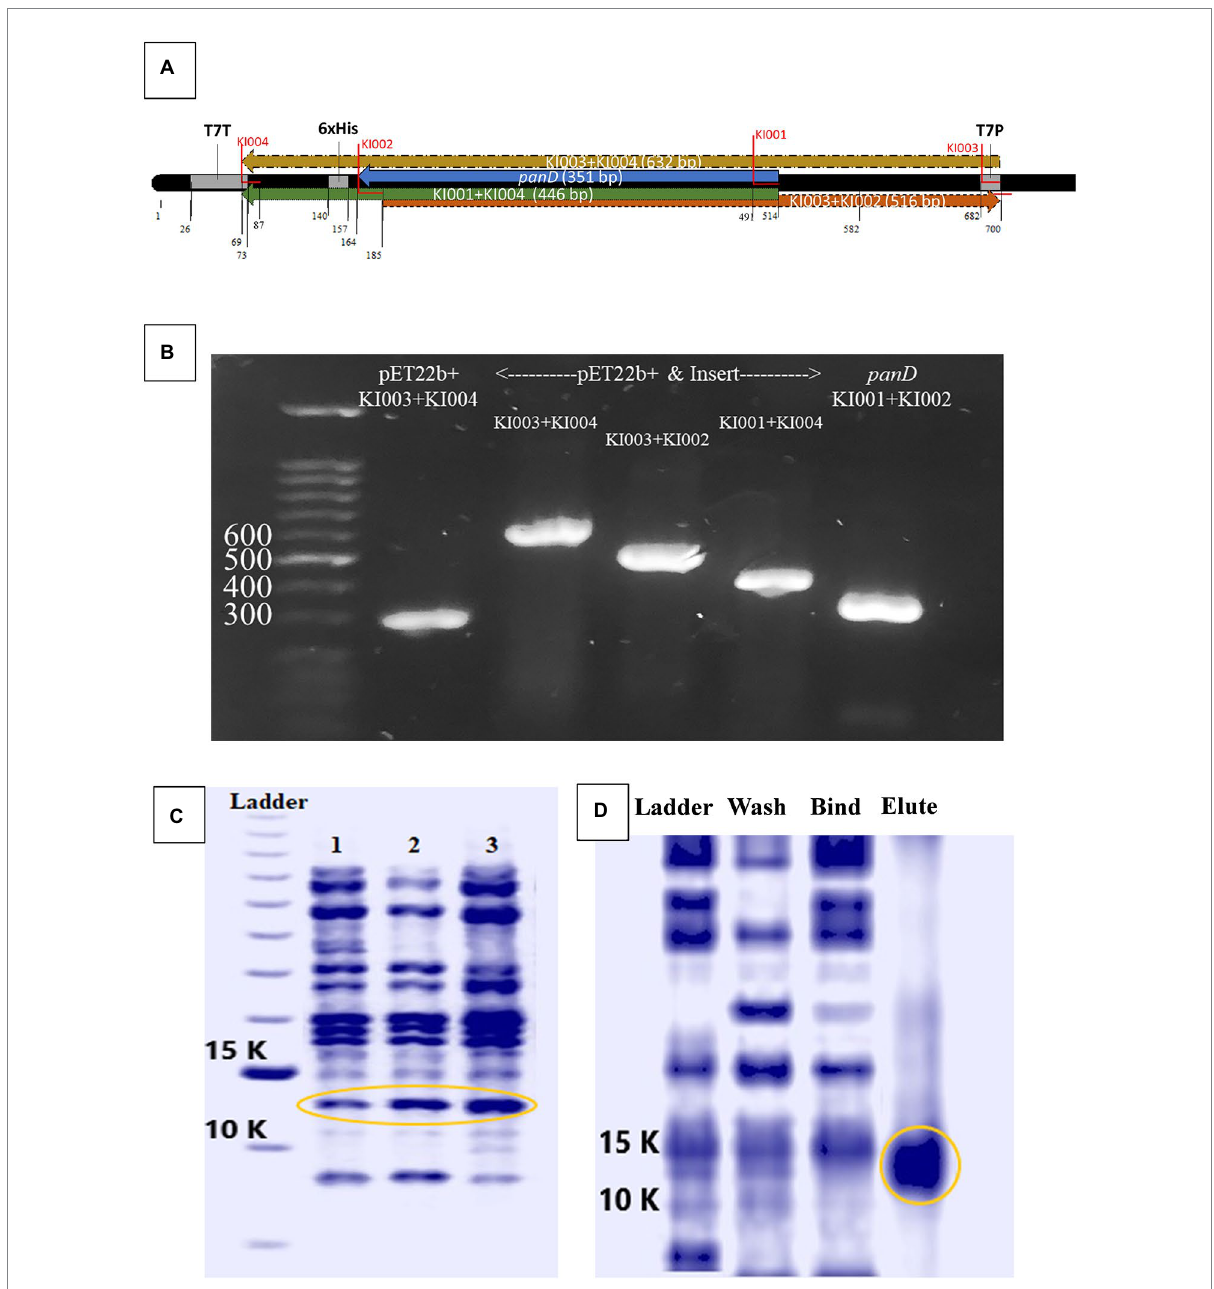
FIGURE 3 Cloning and expression of Helicobacter pylori ATCC 43504 aspartate α -decarboxylase. (A) Schematic diagram generated by BioEdit (7.2.5., 2015) of pET22b + vector containing the pan D insert with the positions of different primers highlighted. (B) Polymerase chain reaction (PCR) amplicons produced by different primer combinations performed on H . pylori ATCC 43504 DNA ( pan D), empty pET22b(+) plasmid vector and the recombinant plasmid vector pET22b(+) containing the insert pan D, (C) Crude protein extract from: lane 1: Escherichia coli BL21, lane 2: E . coli BL21/RecPl induced by 0.5 mM Isopropyl β -D-1-thiogalactopyranoside (IPTG), lane 3: E . coli BL21/RecPl induced by 0.75 mM IPTG (D) The wash, bind and elute of Ni-NTA columns purification of the recombinant protein from E . coli